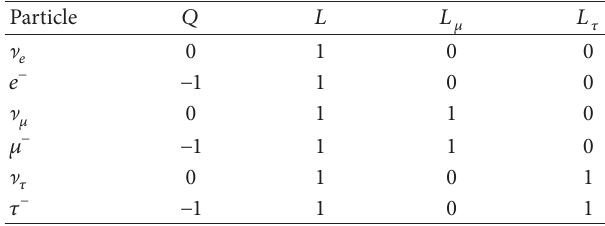
Table 1: SM additive quantum numbers for leptons.